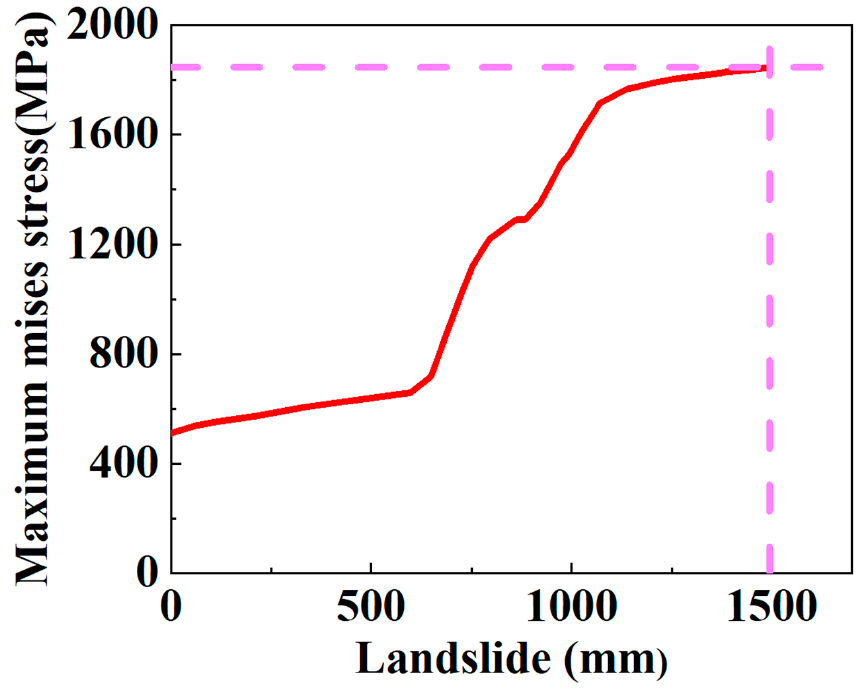
Figure 14. Variation in the maximum Mises stress of steel wires with the landslide.